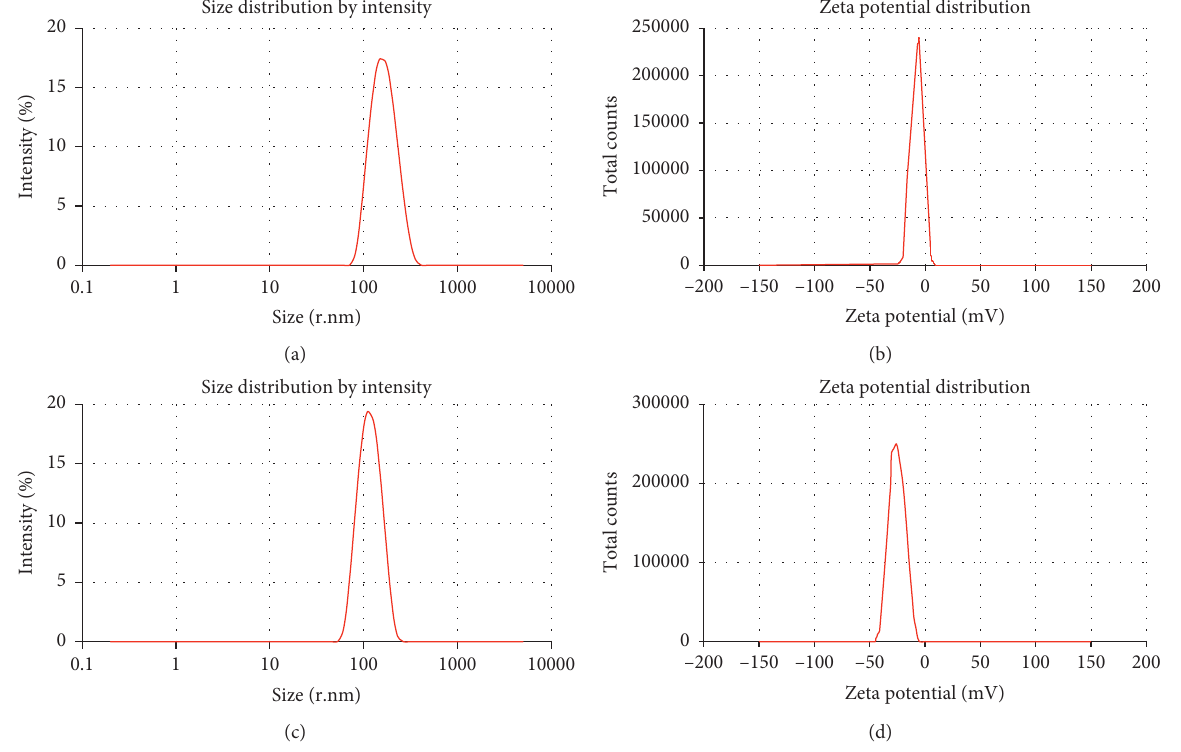
Figure 4: The average particle size (a, c) and zeta potential (b, d) of LZN (a) and LZHN